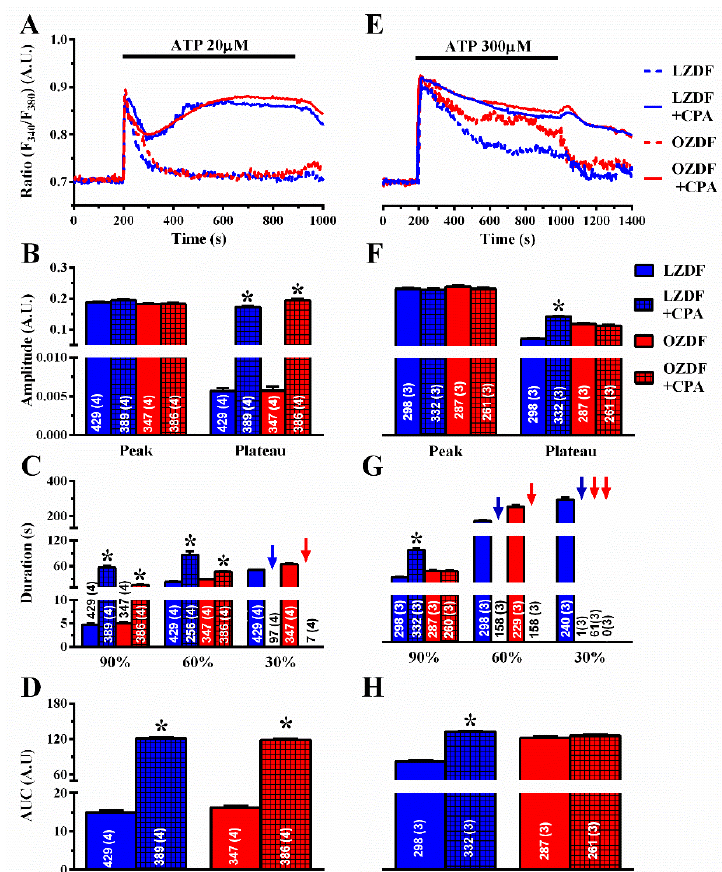
Figure 6. The e ff ect of CPA on the Ca 2 + response to ATP is larger in native aortic endothelium of obese Zucker diabetic fatty rats. ( A ) Representative recordings of the Ca 2 + response to 20 µ M ATP in the absence or presence of 10 µ M CPA in native aortic endothelium of LZDF and OZDF rats. In CPA experiments, ATP and CPA were applied at the same time. ( B ) Mean ± SE of endogenous Ca 2 + release and SOCE amplitude recorded in native aortic endothelium of LZDF and OZDF rats challenged with 20 µ M ATP in the absence or presence of 10 µ M CPA. The asterisk indicates p < 0.05. ( C ) Mean ± SE of the duration of the two distinct components (i.e., endogenous Ca 2 + release and SOCE) of the Ca 2 + response to 20 µ M ATP recorded in native aortic endothelium LZDF and OZDF rats challenged with 20 µ M ATP in the absence or presence of 10 µ M CPA. The asterisk indicates p < 0.05. Blue and red arrows indicate that the Ca 2 + signal failed to reach the clearing rate to the 30% of the initial peak amplitude in LZDF and OZDF rats respectively. ( D ) Mean ± SE of the AUC of the two distinct components (i.e., endogenous Ca 2 + release and SOCE) of the Ca 2 + response to 20 µ M ATP recorded in native aortic endothelium of LZDF and OZDF rats in the absence or presence of 10 µ M CPA. The asterisk indicates p < 0.05. ( E ) Representative recordings of the Ca 2 + response to 300 µ M ATP in the absence or presence of 10 µ M CPA in native aortic endothelium of LZDF and OZDF rats. In CPA experiments, ATP and CPA were applied at the same time. ( F ) Mean ± SE of endogenous Ca 2 + release and SOCE amplitude recorded in native aortic endothelium of LZDF and OZDF rats challenged with 300 µ M ATP in the absence or presence of 10 µ M CPA. The asterisk indicates p < 0.05. ( G ) Mean ± SE of the duration of the two distinct components (i.e., endogenous Ca 2 + release and SOCE) of the Ca 2 + response to 300 µ M ATP in native aortic endothelium of LZDF and OZDF rats in the absence or presence of 10 µ M CPA. Blue and red arrows indicate that the Ca 2 + signal failed to reach the clearing rate indicated in the graph in LZDF and OZDF rats respectively. The asterisk indicates p < 0.05. ( H ) Mean ± SE of the AUC of the two distinct components (i.e., endogenous Ca 2 + release and SOCE) of the Ca 2 + response to 300 µ M ATP in native aortic endothelium of LZDF and OZDF rats in the absence or presence of 10 µ M CPA. The asterisk indicates p < 0.05, Mann-Whitney